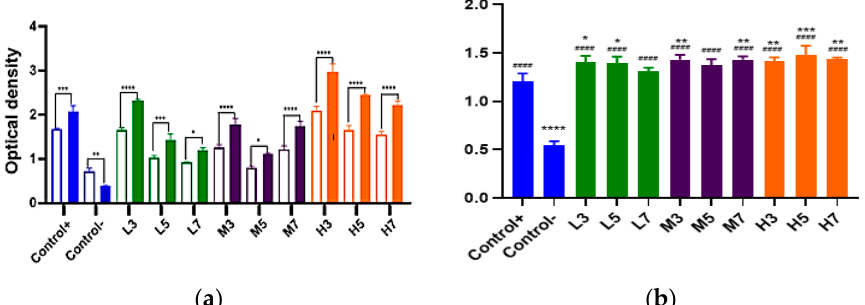
Figure 7. OD values of cells on the control slides and the GO-coated film, analyzed by the CCK-8